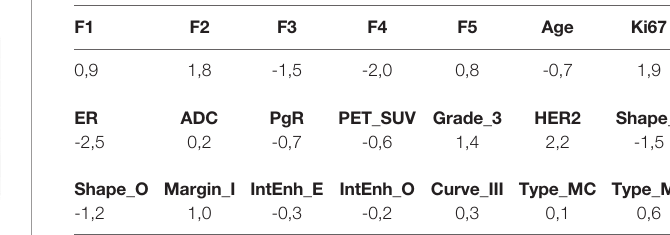
TABLE 2 | Regression correlation coef fi cients of the single covariates in the Logit